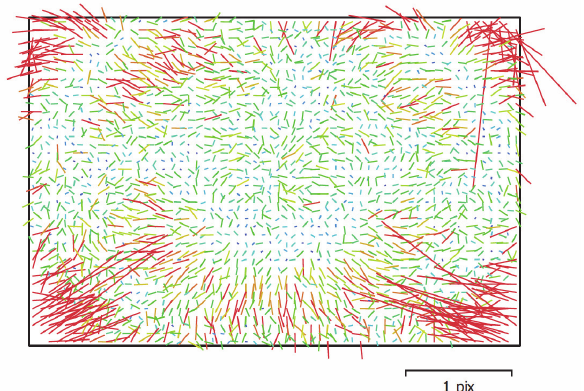
Figure 6. Image residuals of Sony ILCE-6000 (QuestUAV)